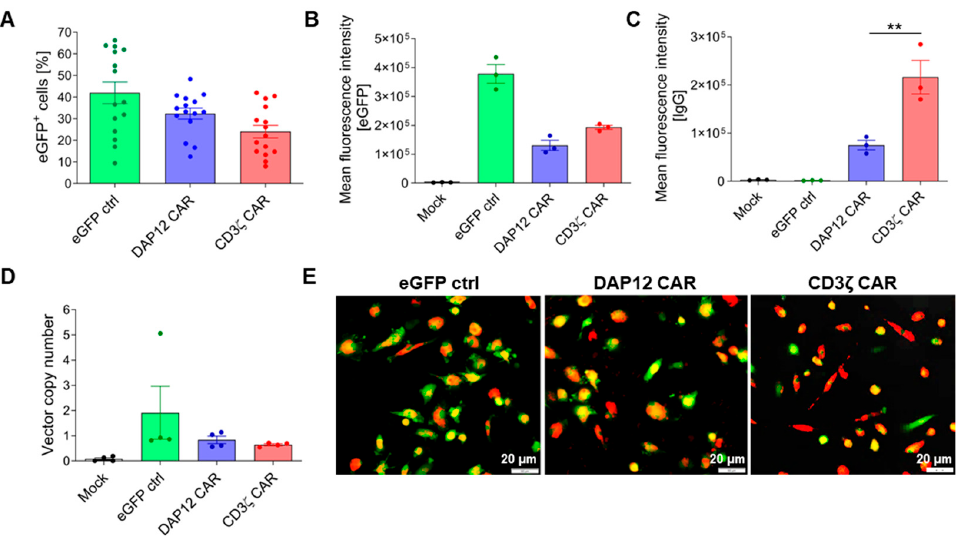
Figure A3. Validation of efficiency and M Φ characteristics after lentiviral transduction of HPSCs. ( A ) Transduction efficiencies in CD34 + cells using an MOI 5 ( n = 15). Flow cytometric analysis of ( B ) eGFP and ( C ) CAR expression was determined in sorted and differentiated M Φ s using an antibody to detect the IgG of the CAR constructs. Data are represented as the mean ± s.e.m. of n = 3 biological replicates. ( D ) Vector copy number analysis via qPCR. Data are represented as the mean ± s.e.m. of n = 4 biological replicates. ( E ) pHrodo-based analysis of phagocytic cells via fluorescent microscopy (20× magnification, scale bar: 20 µm). Statistical significance was calculated with one-way ANOVA using multiple comparisons (** indicates p < 0.01). Mock: untransduced CD34-derived M Φ s; ctrl: control.